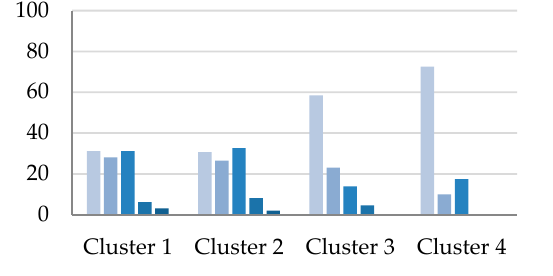
Figure 4. Characteristics of clusters, based on subjective assessment of Industry 4.0 (I4): ( a ) subjective assessment of Industry 4.0 implementation by enterprises (very low, low, medium, high, or very high implementation of I4) and ( b ) clusters according to the existence of I4 strategy in enterprises.